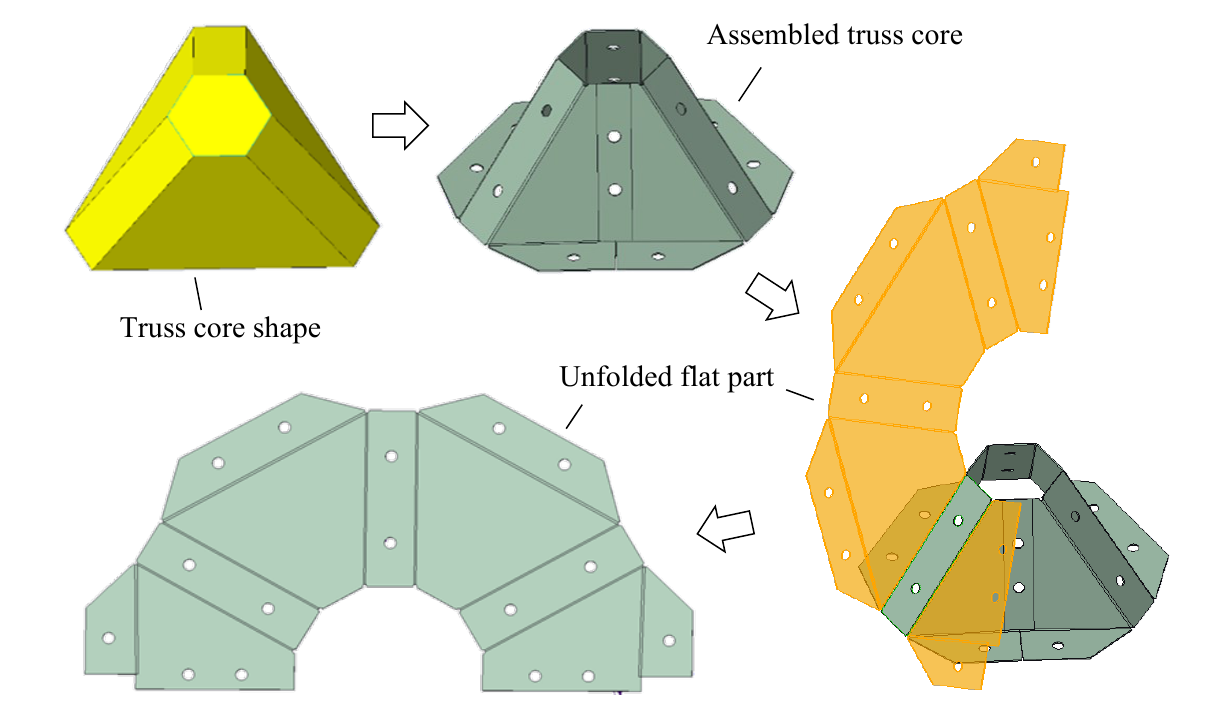
Figure 4. Construction of the flat plate parts of the assembled truss core.